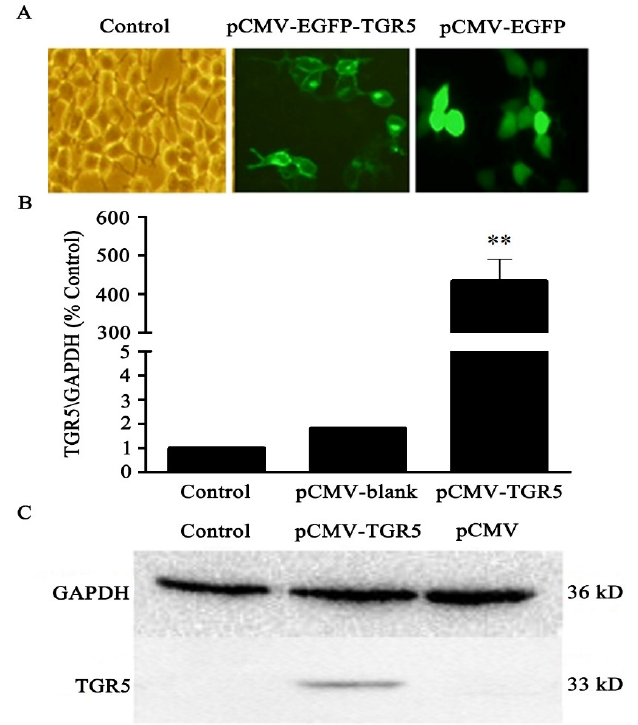
Figure 2. TGR5 mRNA and protein expression in 293T cells. ( A ): PCMV-EGFP-TGR5 labeled with the green fluorescent label can detect green fluorescence in 293T cell cells under a fluorescence microscope, which showed that PCMV-EGFP-TGR5 was expressed in 293T cells; ( B ): the 293T cells transfected with pCMV-TGR5 plasmid after TGR5 expression was increased compared to the control and pCMV-blank groups; ( C ): Western blot identified TGR5 recombinant protein. Data represents of means ± S.D. of three independent experiments. ** p < 0.01 vs. control .